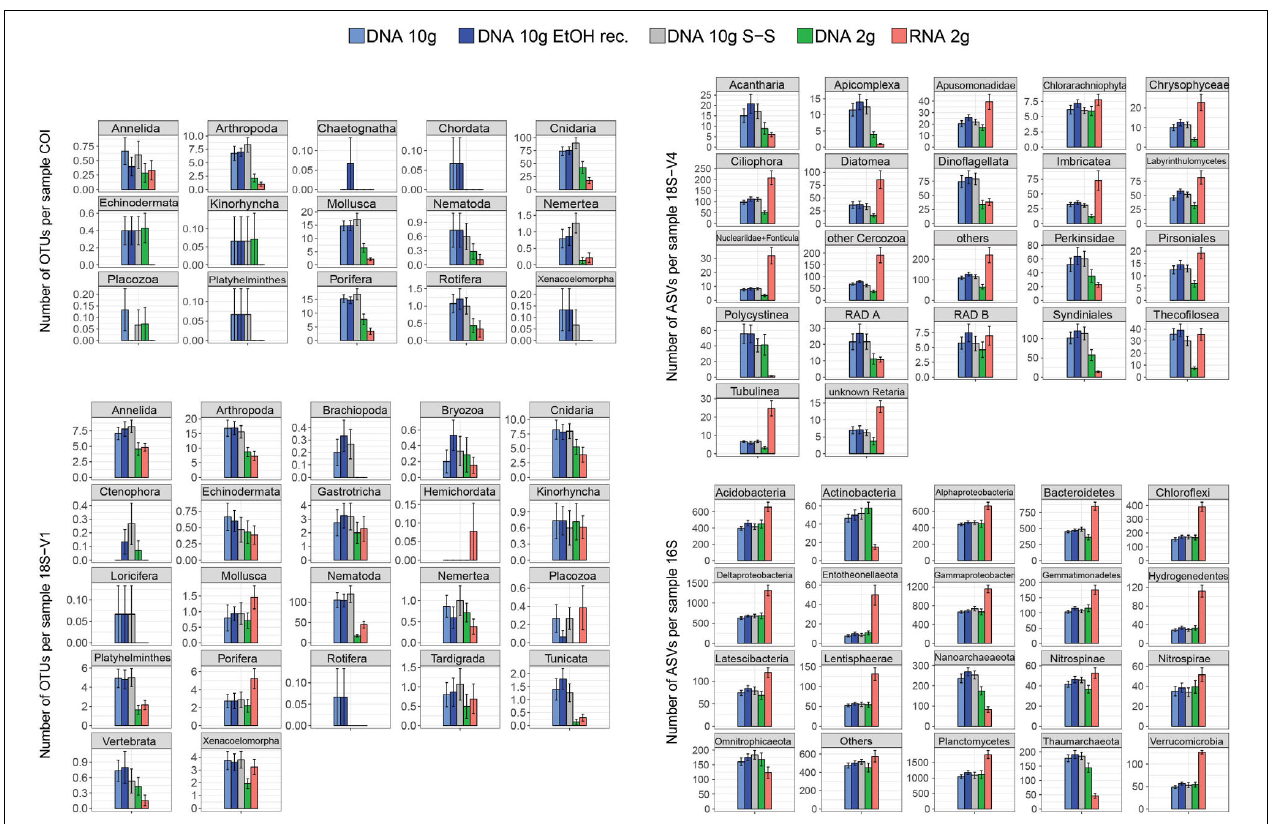
FIGURE 2 | Mean number of metazoan operational taxonomic units (OTUs) (COI, 18S-V1), protist amplicon sequence variants (ASVs) (18S-V4), and prokaryote ASVs (16S) detected per sample for each of the five processing methods (DNA 10 g: crude DNA extracts from ∼ 10 g of sediment with the PowerMax Soil kit; DNA 10 g EtOH rec. EtOH reconcentrated 10 g DNA extracts; DNA 10 g S-S: size-selected 10 g DNA extracts; DNA/RNA 2 g: crude DNA/RNA extracts from ∼ 2 g of sediment with the RNeasy PowerSoil kit). Cluster numbers were calculated on rarefied datasets. Error bars represent standard